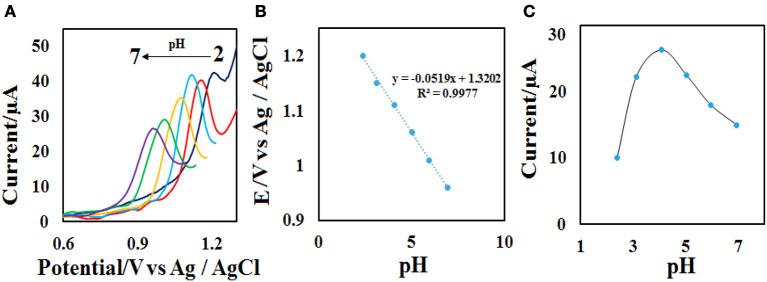
(A) DPVs of the CdO/Fe3O4/CPE at various pH values (2, 3, 4, 5, 6, and 7). (B) Plots of the Ep vs. pH value and (C)
Ip vs. pH value in the presence of 50 μM ACV.